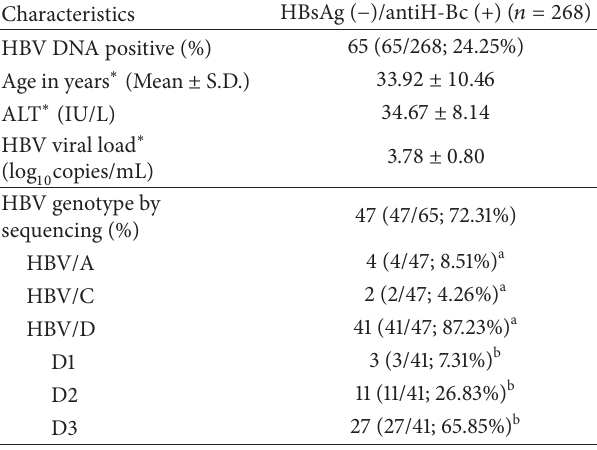
Table 1: Demographic, serological, and virological characteristics of the 65 occult HBV positive blood